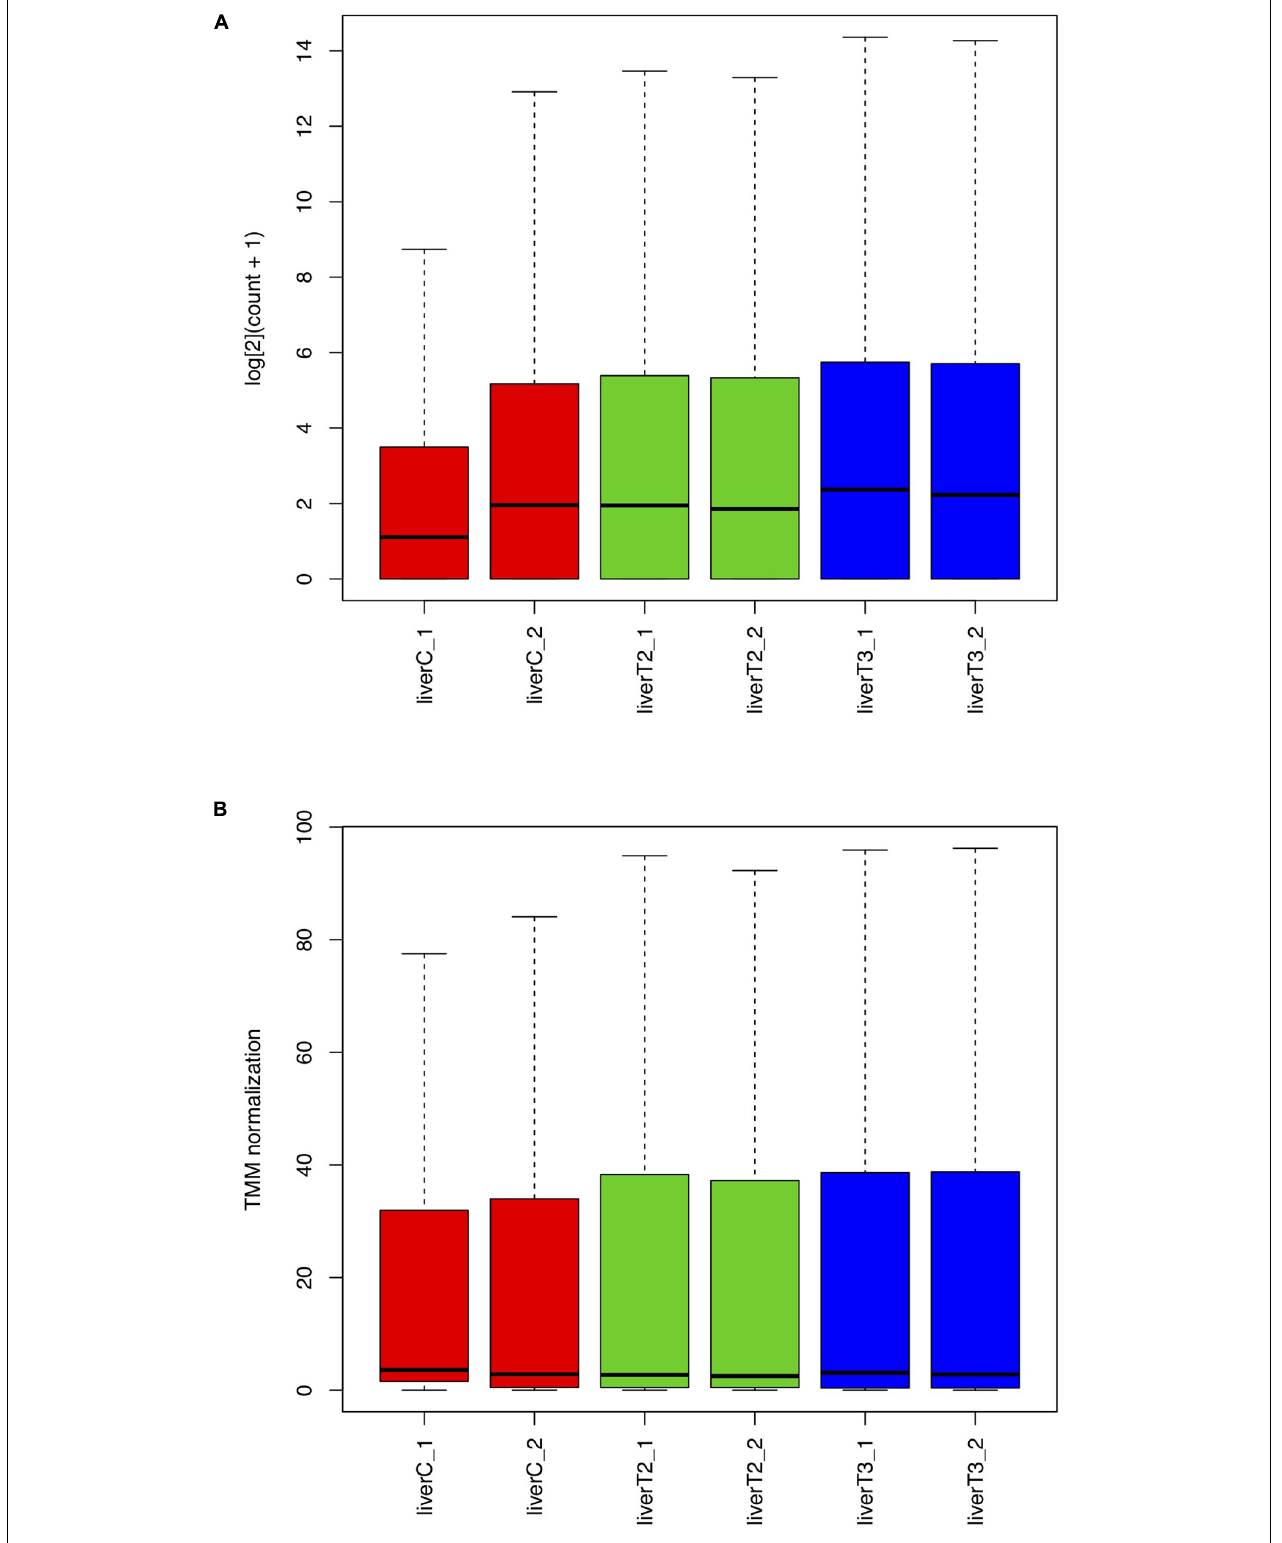
FIGURE 3 | Boxplot with normalized counts. The frequency distribution and some statistics like mean, median and outliers are represented in these plots. (A) log2 normalized counts. (B) TMM normalized counts.